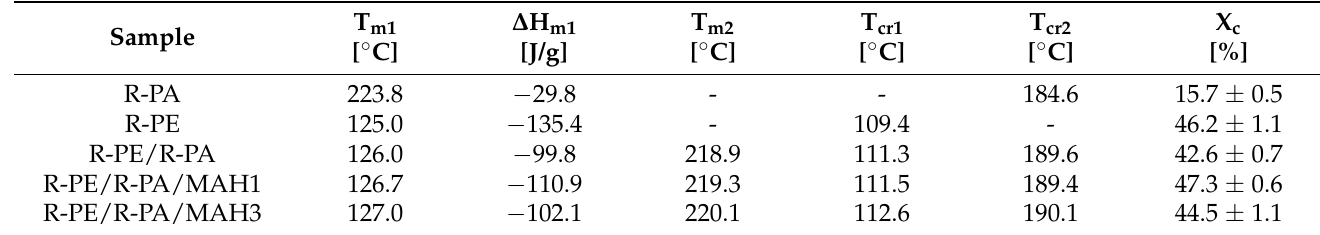
Table 4. DSC data of R-PE, R-PA, R-PE/R-PA, and R-PE/R-PA/MAH blends (second heating at 10 ◦ C/min); X c (%) is the crystallinity degree of polyethylene phase in the